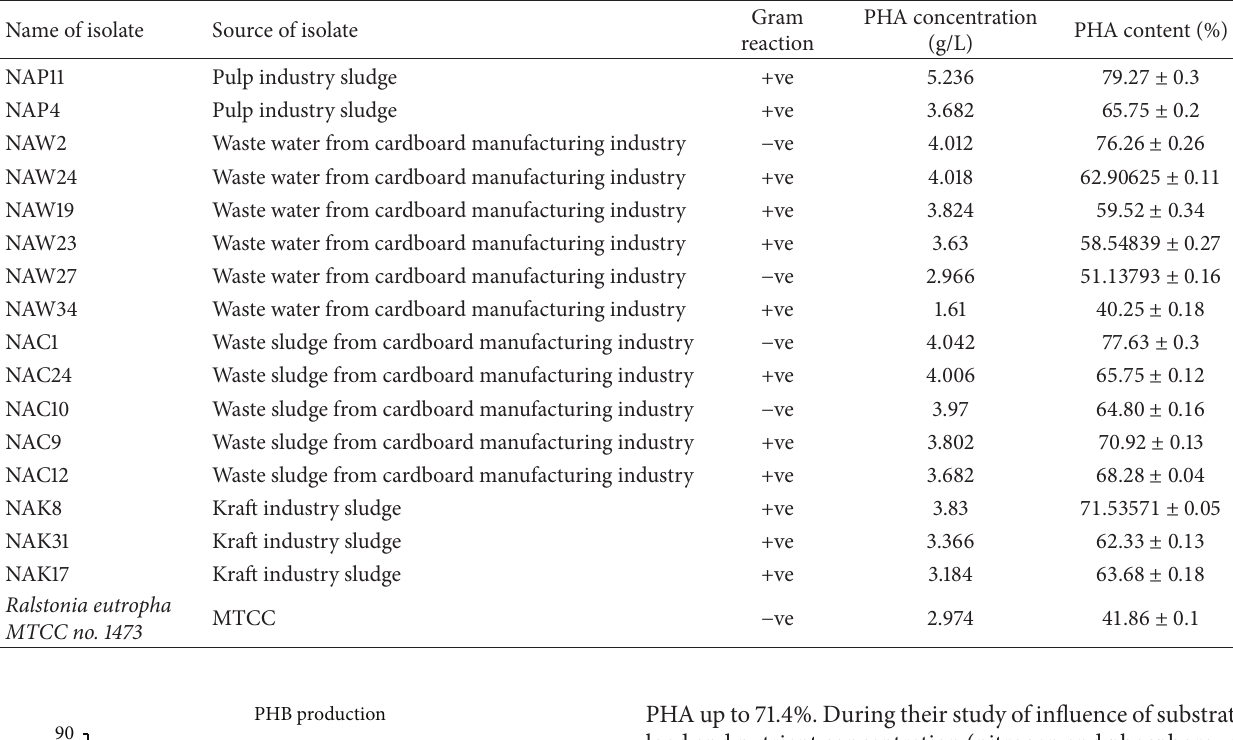
Table 1: List of PHA accumulating bacteria with source of isolation.